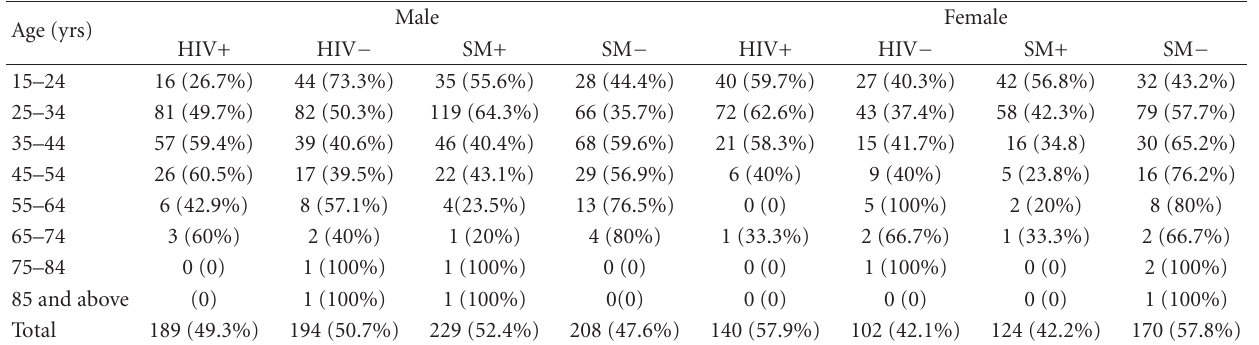
Table 1: Age and gender distribution of culture positive cases by their HIV and smear microscopy status.